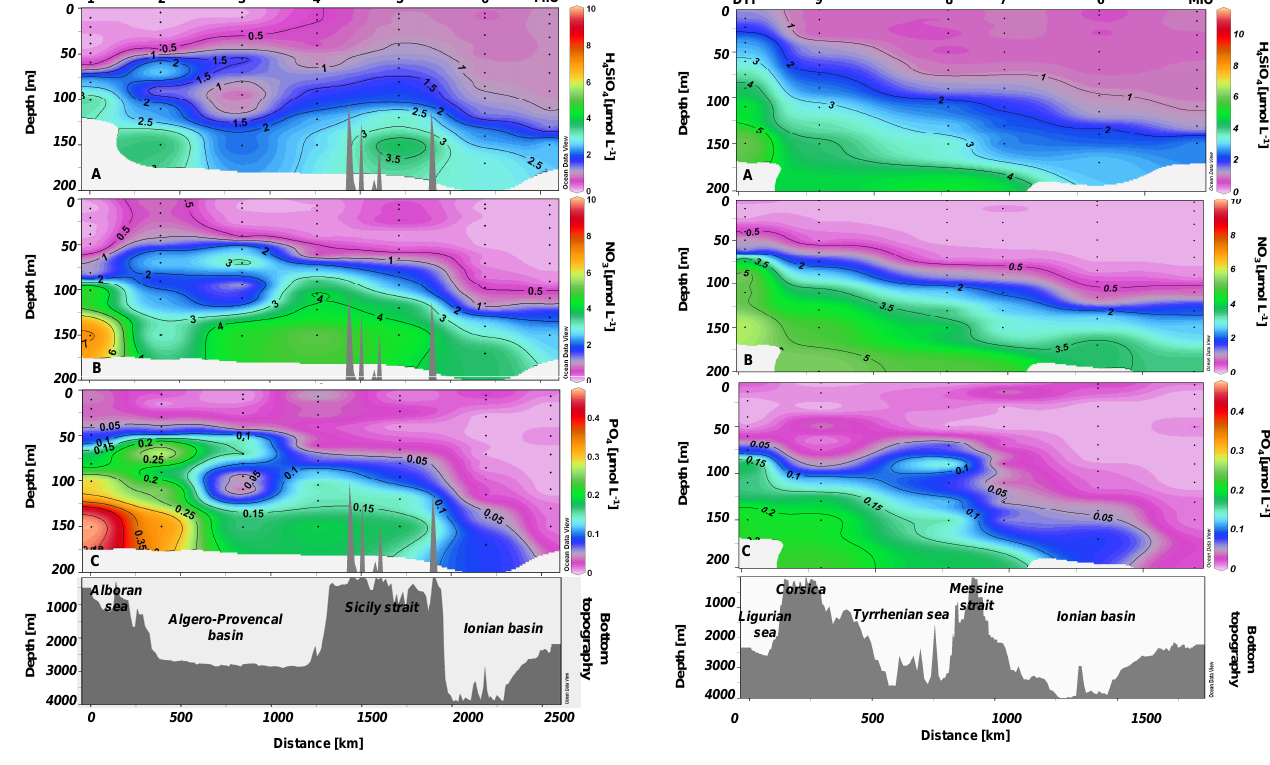
Fig. 2. Nutrient distributions (µM) along the transect 1 during PROSOPE the cruise (summer/fall 1999).